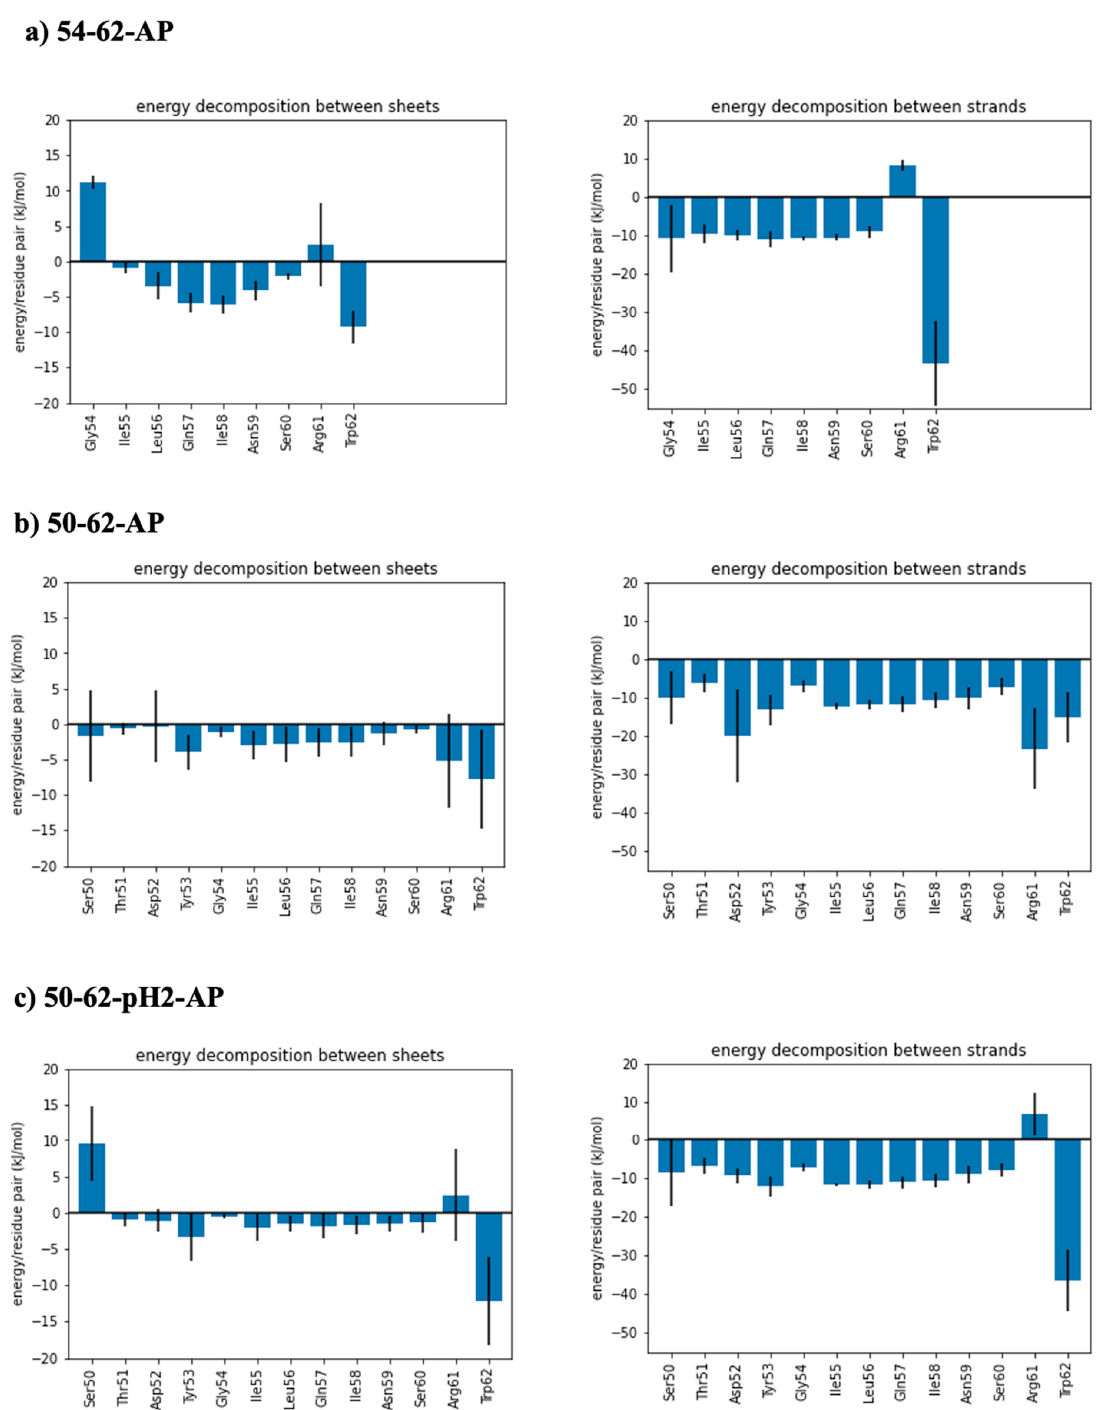
Figure 4. Time-averaged energy decomposition (left) between sheets and (right) between strands of ( a ) antiparallel model of K-peptide (54–62-AP), ( b ) antiparallel model of STDY-K-peptide (50–62-AP), and ( c ) antiparallel model of protonated STDY-K-peptide at pH 2 (50–62-pH2-AP). The roles of Trp62 residues in local interactions within the amyloid structures were further investigated through the radial distribution functions (RDF) between end residues of peptides shown in Figure 5. Figure 5a displays the arrangement of terminal residues within the 54–62-AP model, in which Trp62 (orange) residues at the C-termini are surrounded by Gly54 (green) and Ile55 (white) residues at the N-termini of neighboring peptide